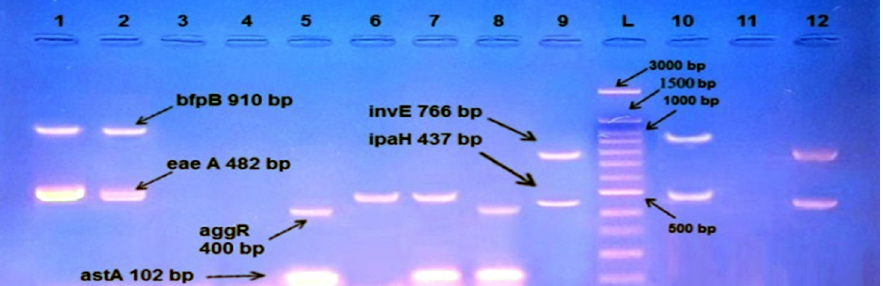
Fig. 3. Gel electrophoresis of amplified ( eaeA, bfpB, aggR, astA, pic, hly, stx1, stx2, invE, ipaH, elt ,estIa, estIb ) genes, the product size (482, 910, 400, 102, 1, 111, 688, 244, 324, 766, 437, 655, 157, 171 (bp) respectively), of E .coli strains using conventional PCR. Agarose 2%, and TBE(1X) at (75 V/cm for 90 min., stained with Ethydium bromide dye and visualized on a UV transilluminator. Lane(L): DNA ladder (100-3000bp) Lanes: (1-12 ) stool samples.